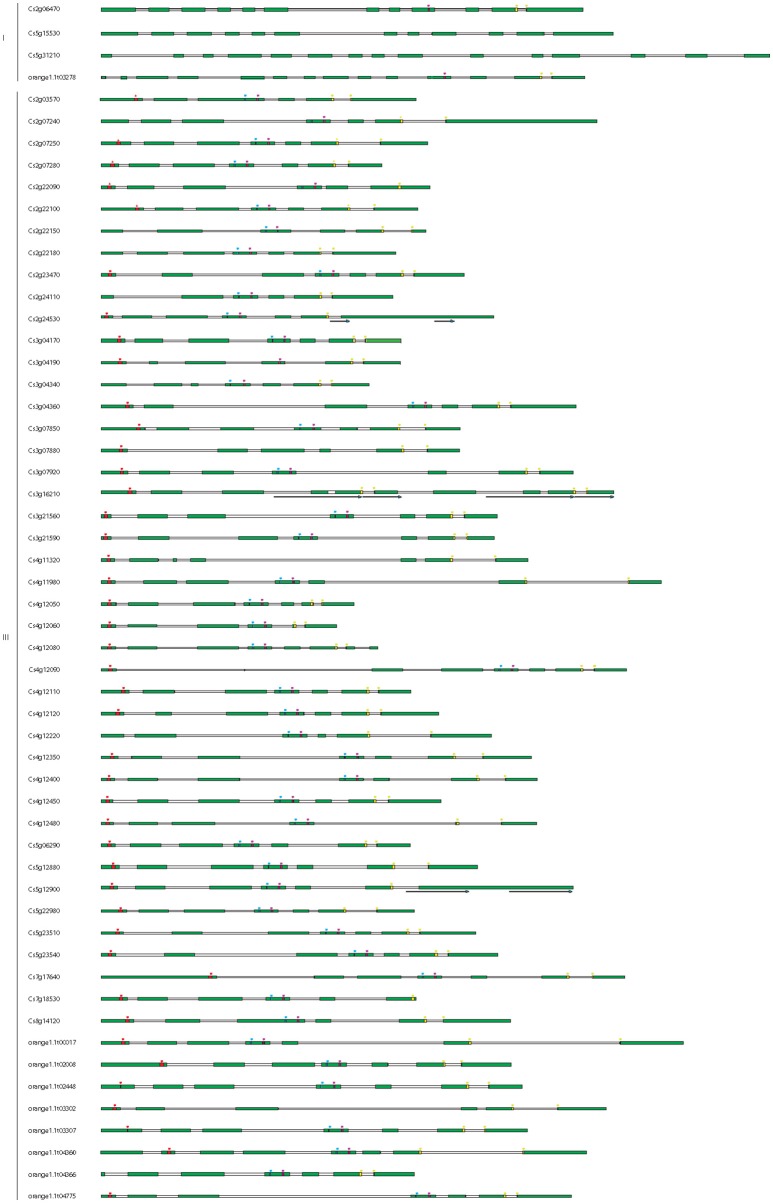
Gene intron-exon structures of the putative full length CsTPS genes identified from the sweet orange genome. The names of the genes are detailed on the left. Introns and exons are represented by white and green boxes, respectively. Red, blue, pink, and yellow asterisks represent conserved motifs RRX8W, RDR, DDXXD, and NSE/DTE, respectively. For more details, see Supplementary Figure 1 and Supplementary Table 5. Duplicated regions are marked by arrows.